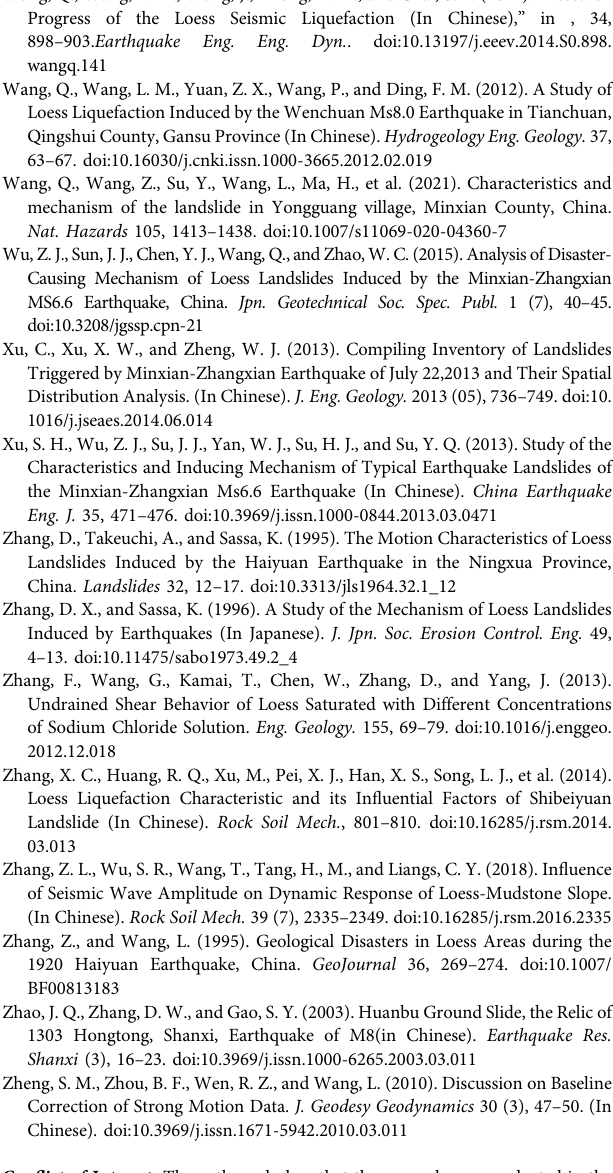
Shaking Table Model Test. Eng. Geology. 86, 118 – 133. doi:10.1016/j.enggeo. 2006.02.011 Liu, K. (2020). Earthquake-Induced Failure Mechanism and Stability Evaluation of Loess Slope under Rainfall Effects (In Chinese) . dissertation ’ s thesis